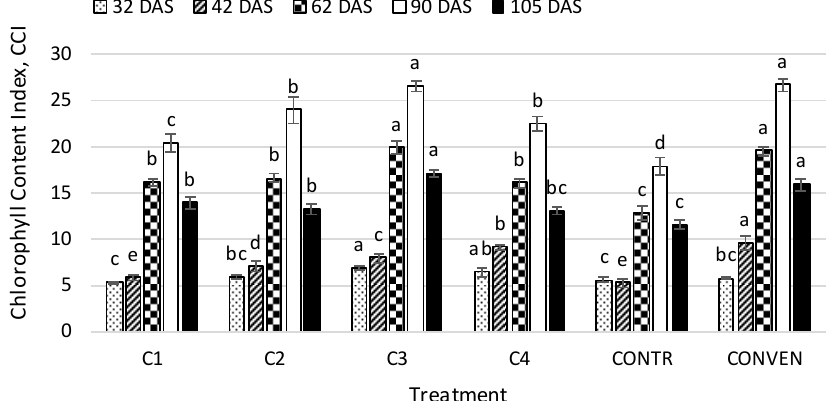
Figure 6. Chlorophyll content index (CCI) of rice plants (means ± se) grown in di ff erently fertilized soil at 32, 42, 62, 90, and 105 days after the sowing (DAS) of the experiments during 2017 and 2018. Treatments contain compost application of (i) 80 kg ha − 1 N in split application (C1), (ii) 160 kg ha − 1 N in split application (C2), (iii) 320 kg ha − 1 N in split application (C3), (iv) 160 kg ha − 1 N in single application (C4), (v) an untreated control (CONTR), and (vi) 160 kg ha − 1 nitrogen chemical fertilizer (CONVEN). Means were compared by the Bonferroni adjusted LSD value at p < 0.05. Di ff erent letters characterize significant di ff erences between treatments for each DAS. Full description of the treatments examined is given in Table 3.